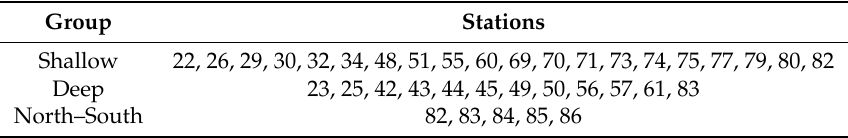
Table 1. Station